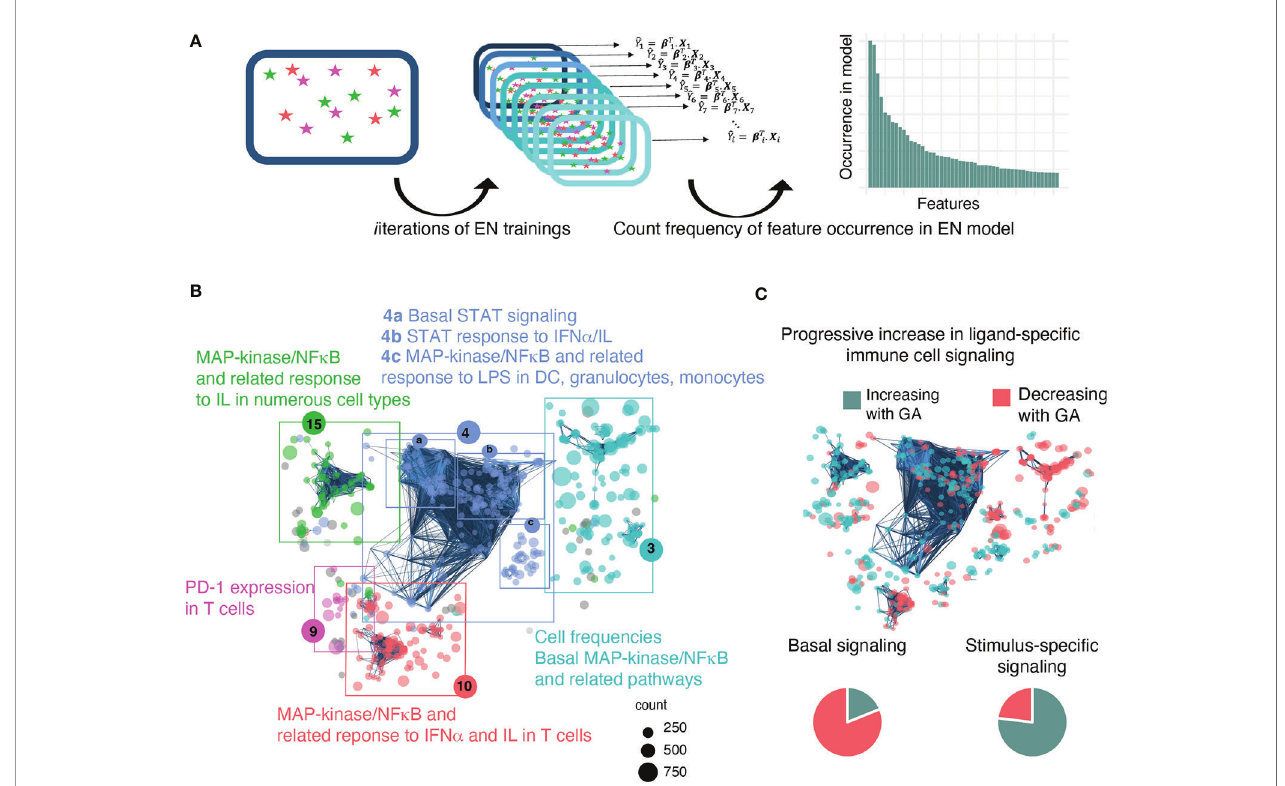
FIGURE 3 | A bootstrap procedure with agnostic clustering reveals patterns in the immune system that change with advancing GA and suggests a progressive increase in ligand-speci fi c responsiveness of the immune system. (A) Analytical work fl ow for the bootstrap procedure used to identify immune correlates of GA. Boxes with stars represent a data set, Xi, that can be used for EN training. We ran the EN model 1,000 times on random sub-samples of the data with replacement and then tallied the number of times an individual feature was selected in one of the bootstrap iterations. (B) The 609 immune features identi fi ed by the bootstrap procedure are highlighted on the correlation network of immune features and agnostically clustered into immunologically relevant communities, revealing patterns in the immune system that vary with respect to GA. The 5 communities that contain 95% of the features are annotated based on the immunologic trends contained within them (community 4 could be further sub-divided into 4a-c). Node size corresponds to frequency of occurrence of the feature in bootstrap iterations. (C) Comparison of basal vs ligand-speci fi c responses (i.e. after stimulation by LPS, IFN a , or IL) among informative immune features that correlate linearly with GA [false discovery rate (FDR<0.1] shows that most (81.1%) basal signaling features decrease with advancing GA whereas most (76.9%) ligand-speci fi c features